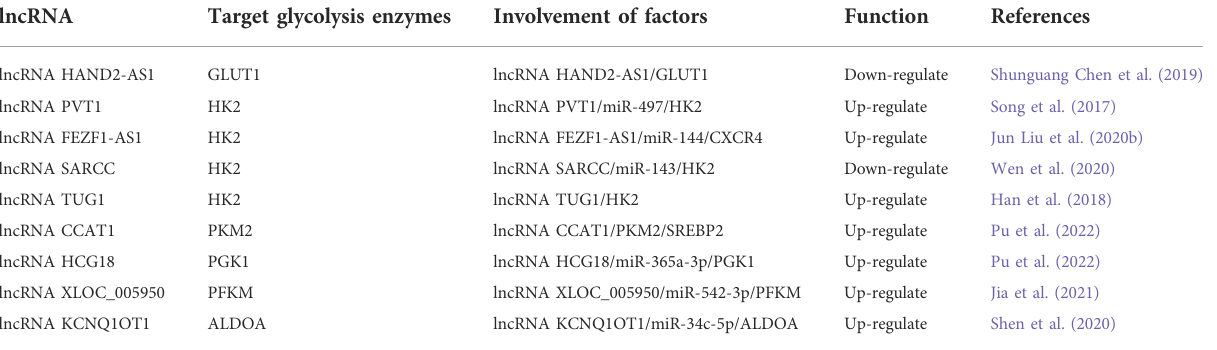
TABLE 4 lncRNAs regulate glycolysis enzymes in osteosarcoma.